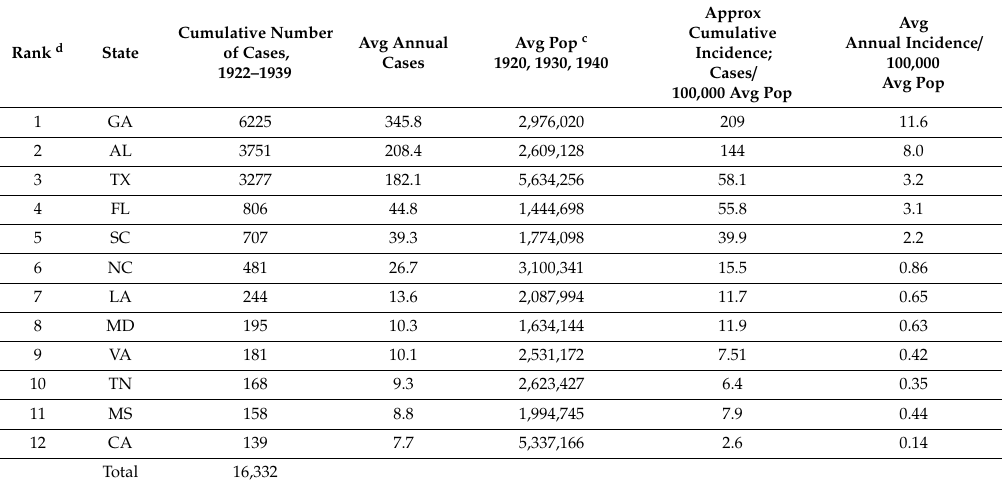
Table 2. Cumulative number of cases and approximate cumulative incidence of flea-borne typhus in the Southeastern states and CA, 1922–1939 a,b